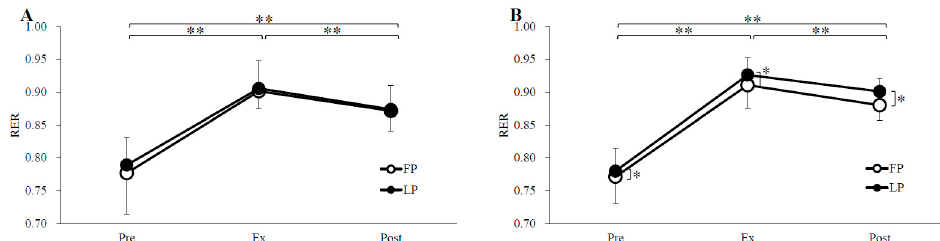
Figure 4. RER for GTE ( A ) and PLA ( B ) trials. FP, follicular phase; LP, luteal phase; RER, the respiratory exchange ratio; Pre, before exercise; Ex, 15 min during exercise; Post, immediately after exercise. * p < 0.05, ** p < 0.01.